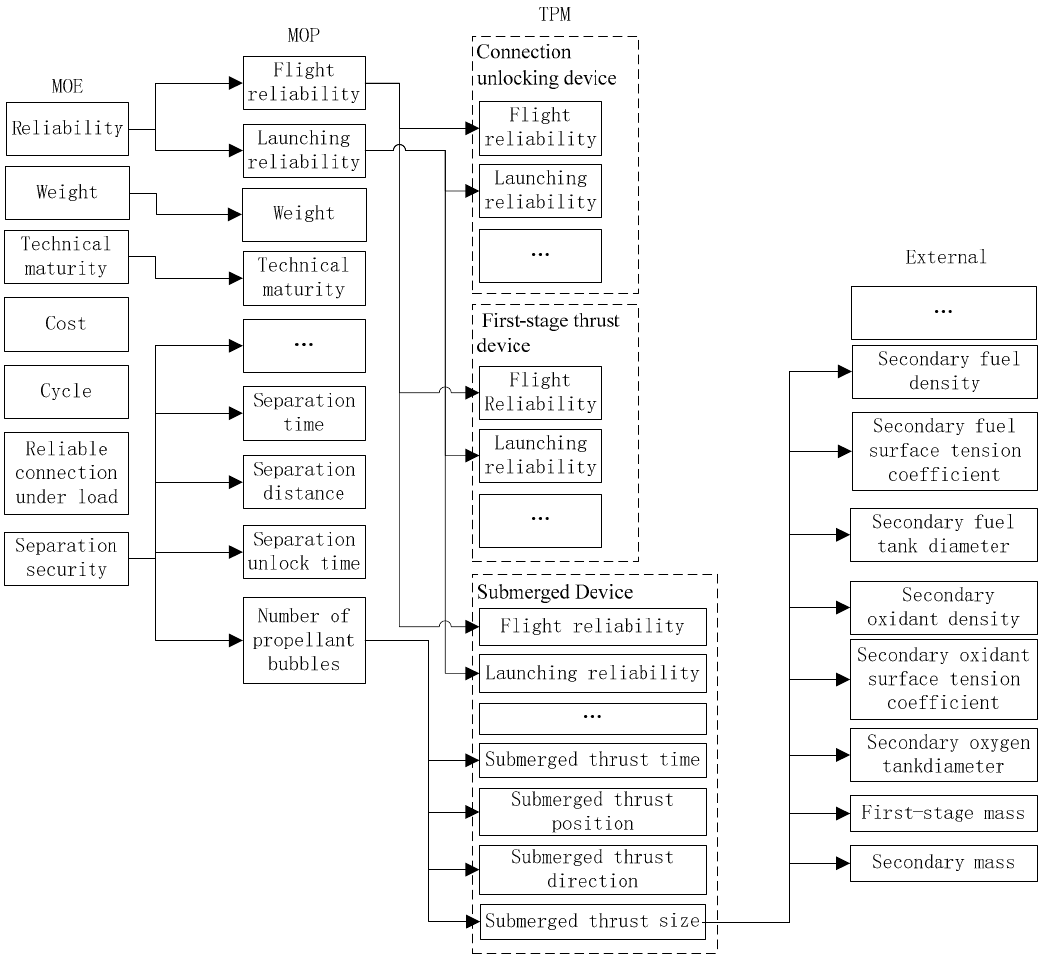
Figure 8. Flow down from MOEs to MOP to TPMs.